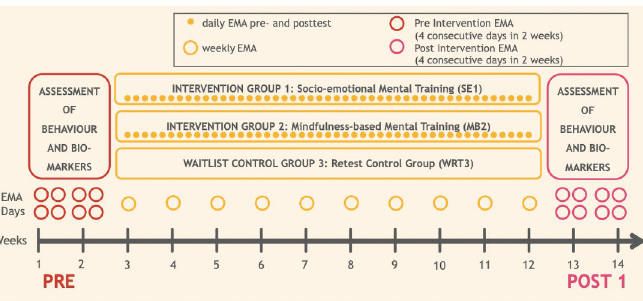
Fig 5. An overview of which measures will be assessed when during the study. Red circles indicate the pre- intervention testing phase, wherein participants will complete the first round of pre-post questionnaires, pre-post behavioral tasks, pre-post EMA and pre-post epigenetic marker assessment. The pink circle indicates the post- intervention testing phase, wherein participants will complete the second round of these measures. The 10 yellow circles indicate the weekly assessments during the intervention. The small solid yellow circles indicate the daily assessments pre and post daily intervention exercise.